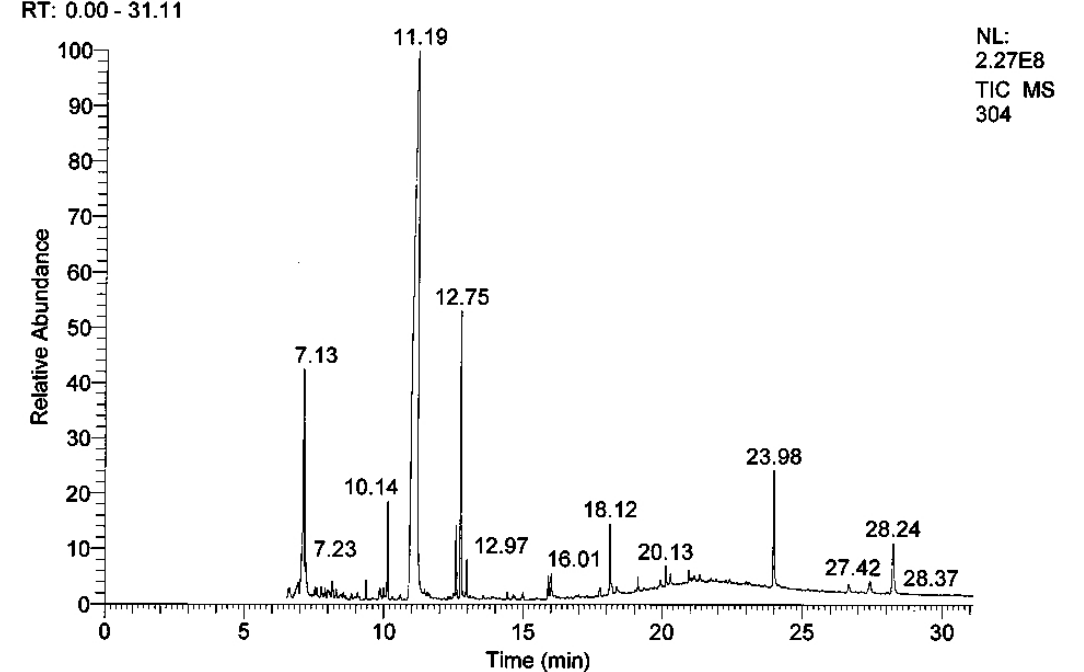
Figure 6. GC-MS/MS chromatogram of Ricinus communis leaf extract (RcExt). Figure 6. GC-MS / MS chromatogram of Ricinus communis leaf extract (RcExt).